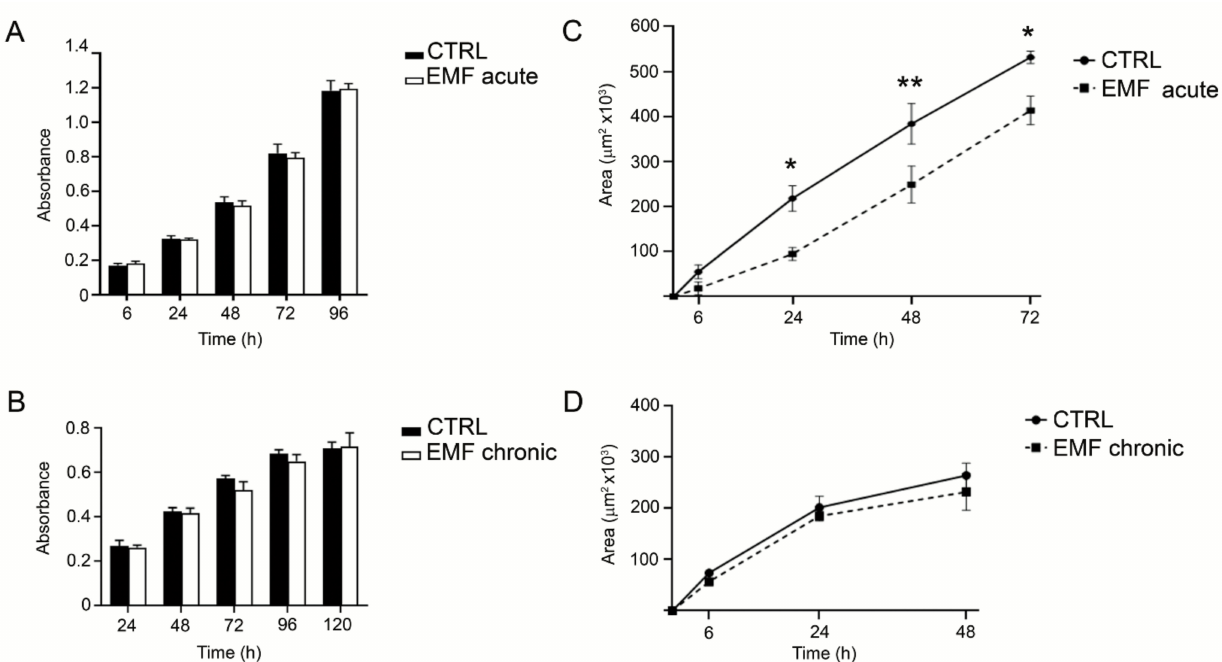
Figure 3. Migration and viability effects on HEI-193 cells exposed to acute and chronic EMF. ( A ) Cell viability was assessed by the MTT assay at 6, 24, 48, 72 and 96 h following a single acute EMF exposure. Each experimental point was in quadruplicate and experiments replicated at least three times; data were expressed as absorbance ± SEM of the mean. ( B ) Cell viability was assessed at 24, 48, 72, 96, and 120 h, following completion of a 5-day chronic EMF exposure. Each experimental point was in quadruplicate and experiments replicated at least three times; data were expressed as absorbance ± SEM of the mean. ( C ) Cell migration was assessed at 6, 24, 48, and 72 h, following a single acute EMF exposure. EMF treatment was associated with a significant decrease in cell migration at 24 (* p < 0.05), 48 (** p < 0.01), and 72 (* p < 0.05) h. Experiments were repeated at least three times. Each data point was calculated as the difference of the 2D scratched area (at time 0) minus the 2D remaining area at each specific time point, representing the 2D area covered by the cell migration. Data were expressed in µ m 2 ± SEM of the mean. ( D ) Cell migration was assessed at 6, 24, and 48 following a chronic EMF exposure. Experiments were repeated at least three times. Each data point was calculated as the difference of the 2D scratched area (at time 0) minus the 2D remaining area at each specific time point, representing the 2D area covered by the cell migration. Data were expressed in µ m 2 ± SEM of the mean. Two-way ANOVA using Sidaki’s post-hoc test was used for statistical